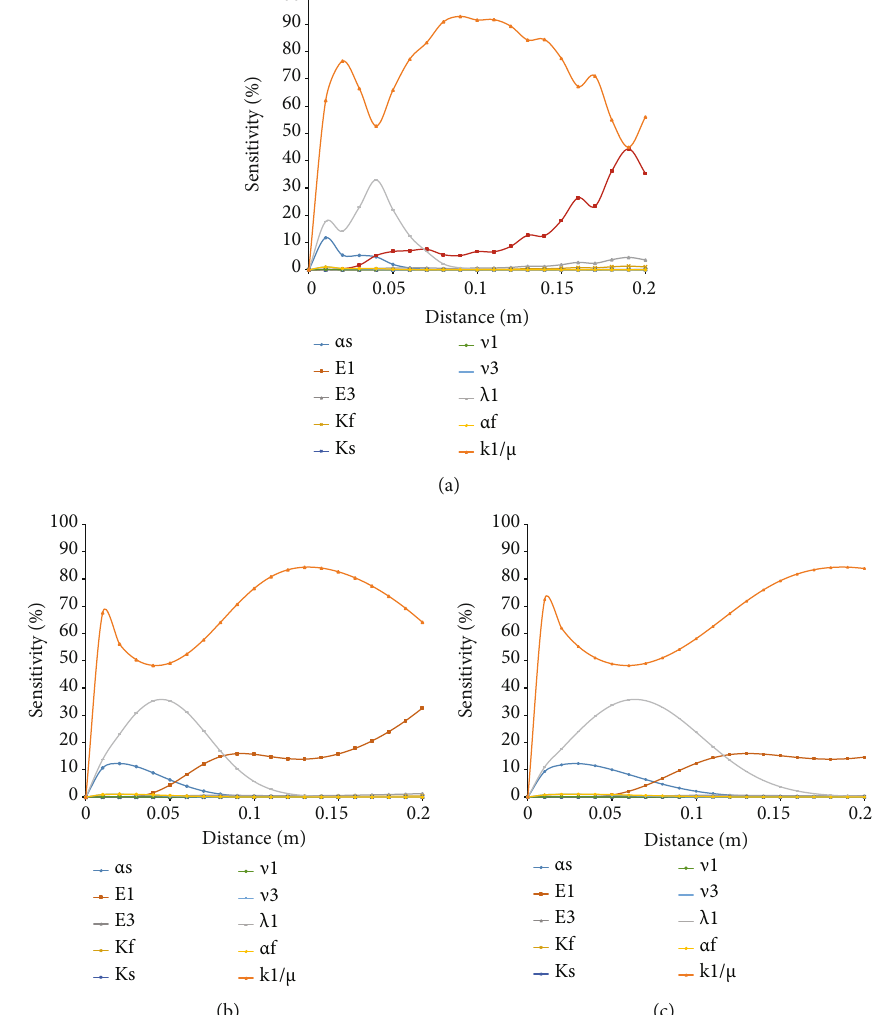
Figure 7: Sensitivity ranking for pressure in the fracture at time (a) t = 15 (min), (b) t = 30 (min), and (c) t = 60